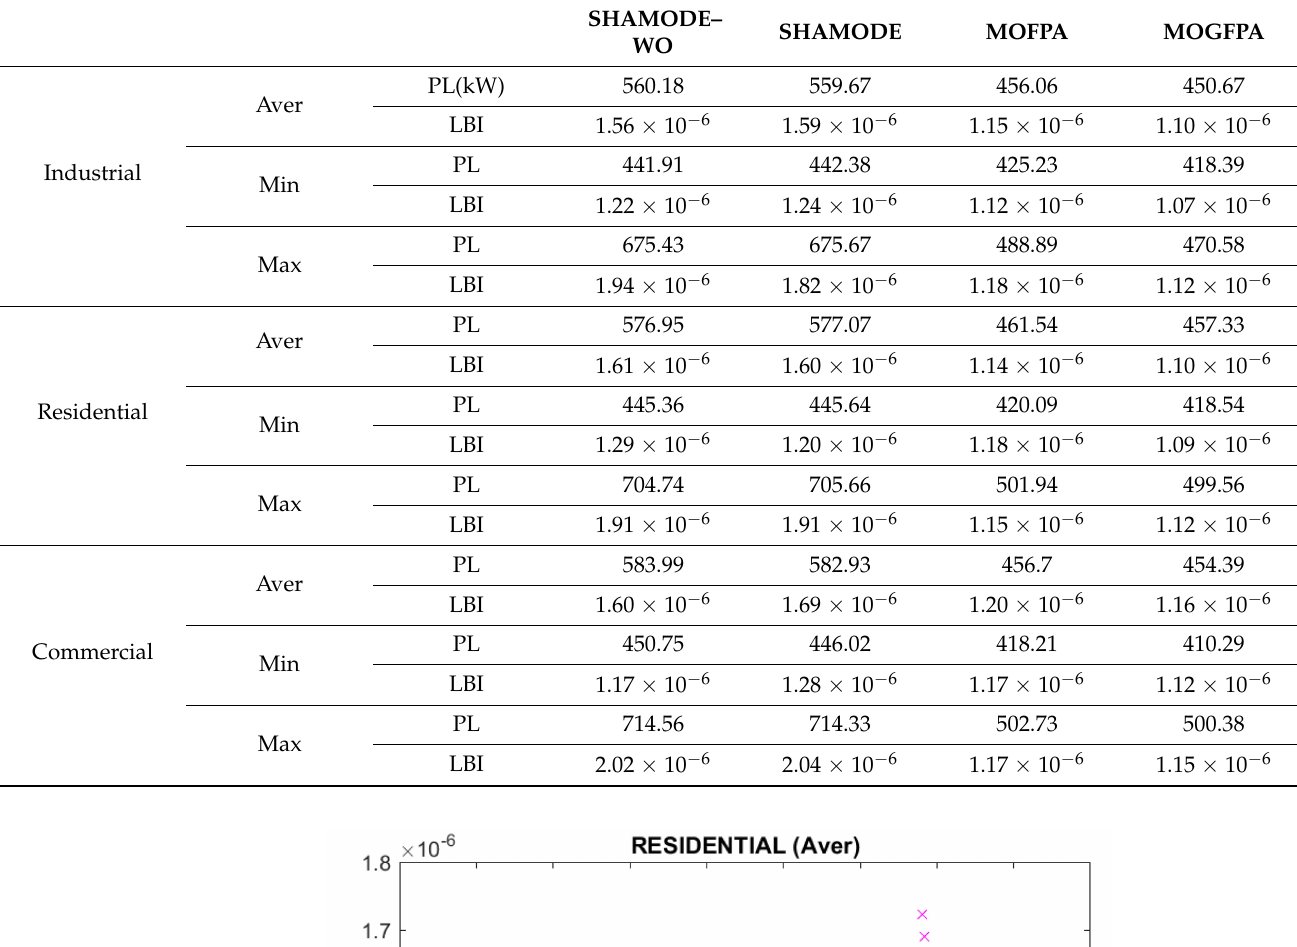
Table 8. PL and LBI comparison under different load conditions for the Indian 52 bus system.